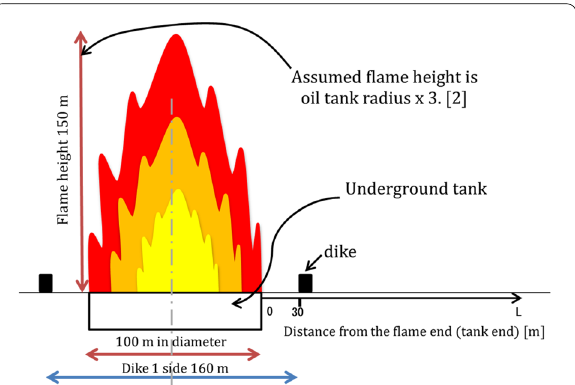
Fig. 4 Dimensional relationship of underground tank fire